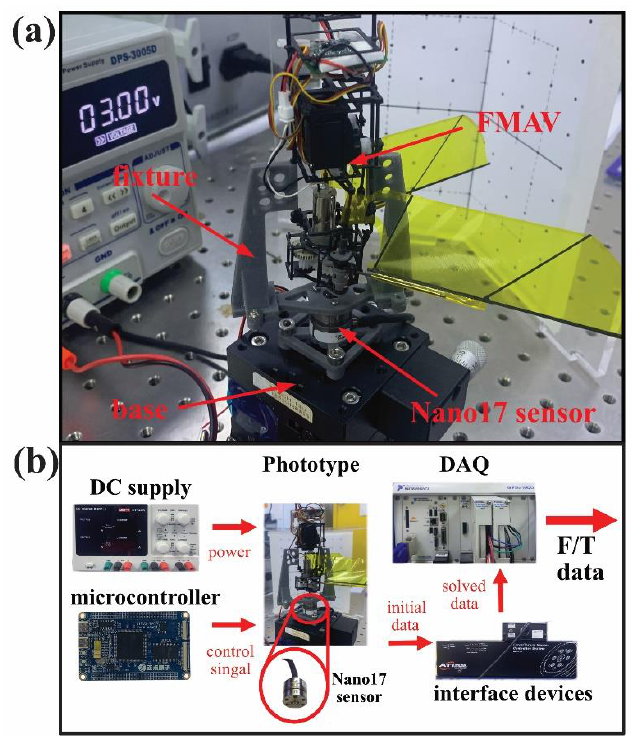
Figure 15. F/T measurement system for lift and total control torque. ( a ) The connection of prototype and sensor. ( b ) The components of the F/T measurement system.